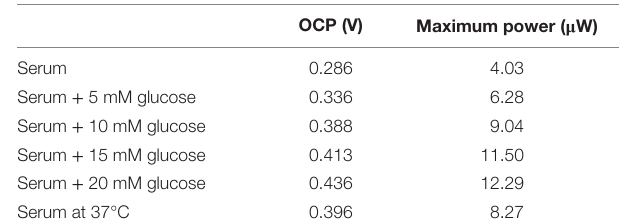
TaBle 1 | summary of the biofuel cell performance results obtained from different human serum